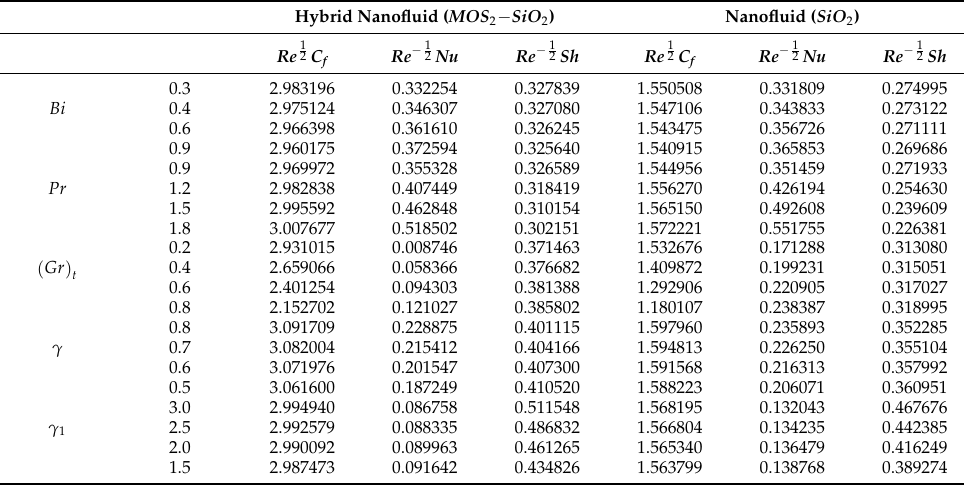
Table 4. Local skin friction coefficient, Nusselt number, and Sherwood number for hybrid nanofluid ( 𝑀𝑂𝑆 (cid:2870) − 𝑆𝑖𝑂 (cid:2870) ) and nanofluid ( 𝑆𝑖𝑂 (cid:2870) ) when 𝑀 = 0.9, 𝑆𝑐 = 0.8, (𝐺𝑟) (cid:3030) = 0.1, 𝐾 =